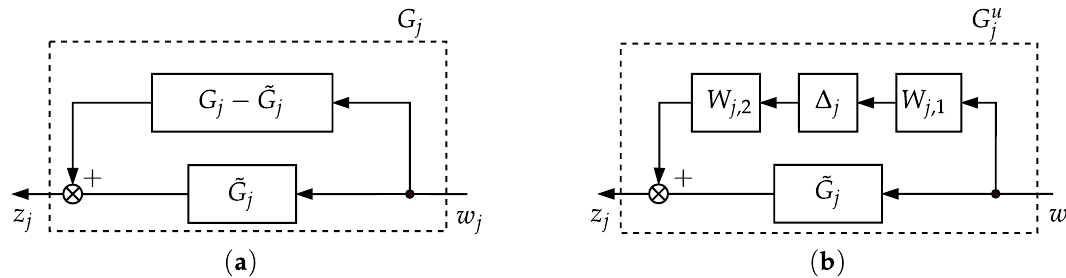
Figure 1. Modelling the absolute error between the original model and the reduced order discretized model as an uncertain dynamical system with additive uncertainty: ( a ) Adding the absolute error ˜ G G j j to the reduced order discretized model − uncertainty W j ,2 ∆ j W j ,1 .